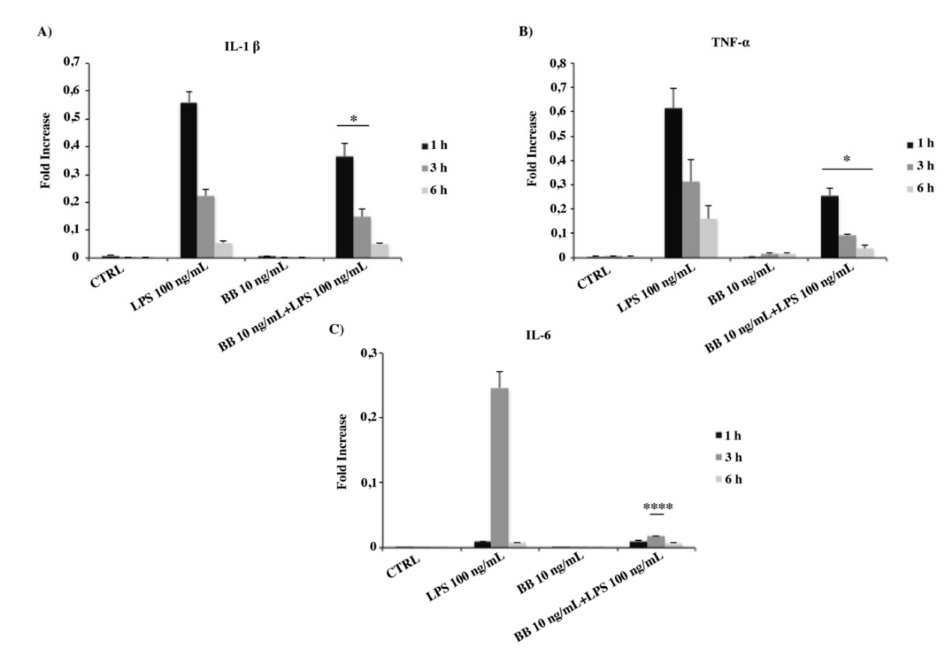
Figure 7. mRNA expression of IL-1 β ( A ), TNF- α ( B ) and IL-6 ( C ) monitored by qPCR and normalized to β -actin. Data are shown as mean ± SD from three independent experiments performed in triplicate. Expression profiles were determined using the 2 − ∆∆ CT method. * p < 0.05 for IL-1 β and TNF- α compared to LPS at the same time points, **** p < 0.0001 for IL-6 compared to LPS at the same time